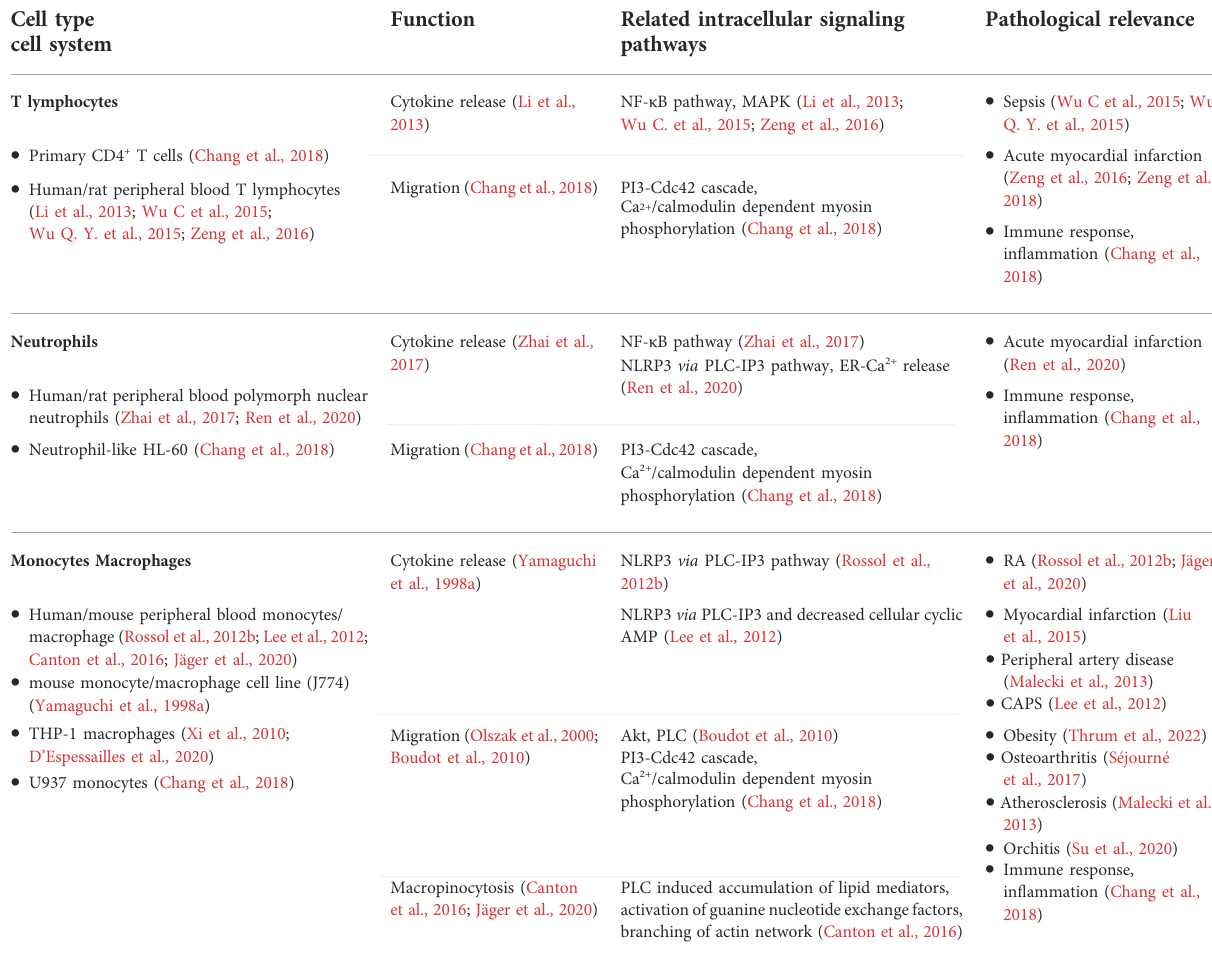
CaSR in immune cells and in fl ammation. Cell type cell